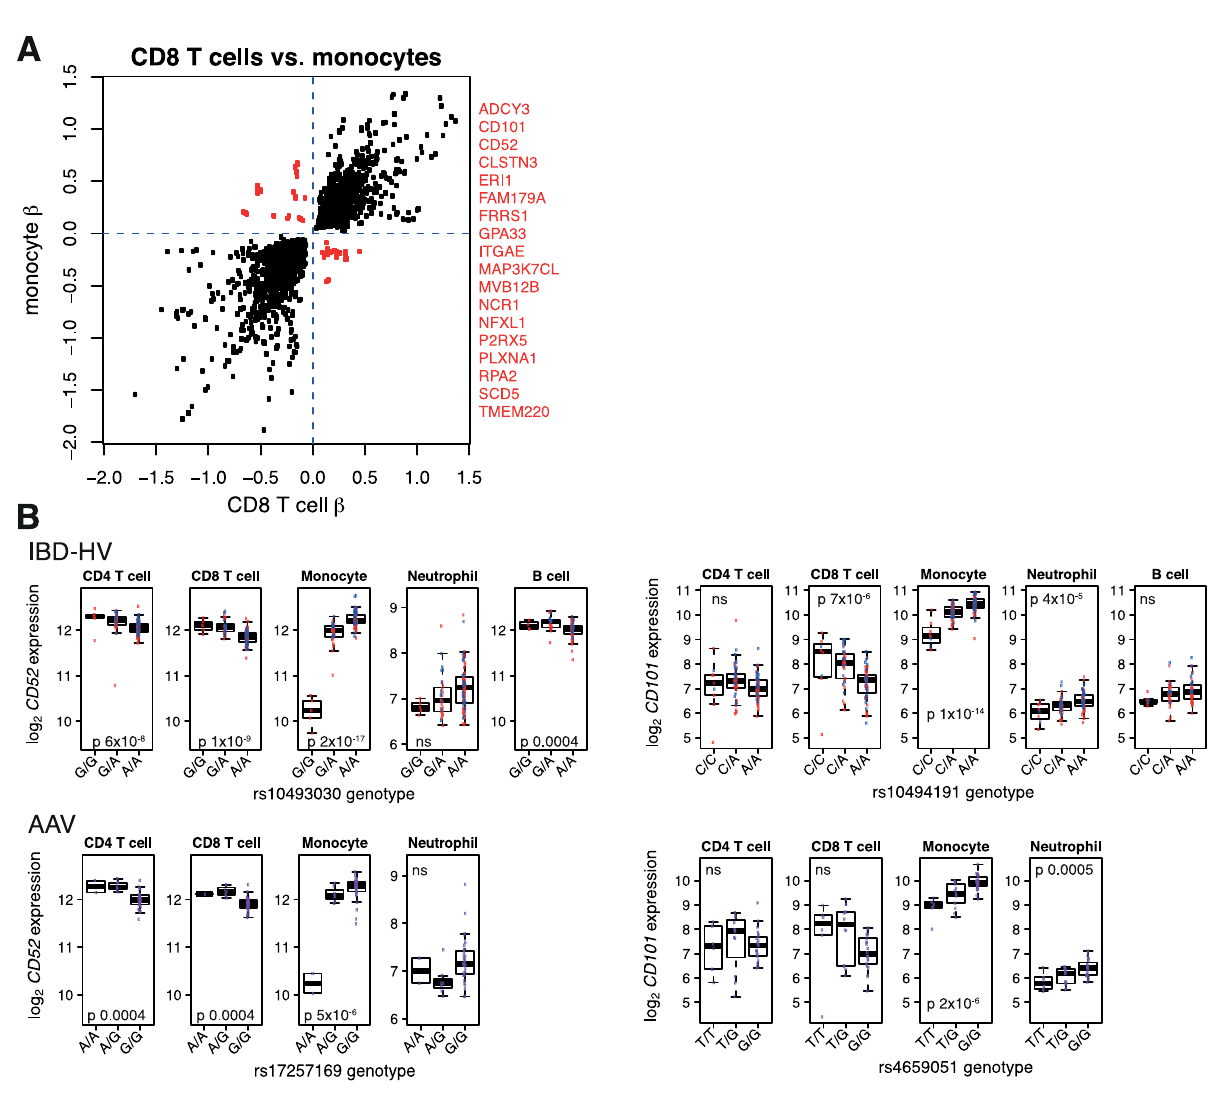
Fig 3. eQTLs with opposing directions of effect between cell types. (A) Detection of eQTLs with opposing directions of effect between CD8 T cells and monocytes (IBD-HV data). Each point represents a SNP-gene association which was significant in both cell types. The axes show the estimated effect size (beta) of genotype on expression in each cell type. SNP-gene pairs with opposing directions of effect between cell types, and the names of these genes, are shown in red. (B) Two examples of such divergent eQTLs. Upper panels: IBD-HV data genotyped on Illumina Human OmniExpress Beadchip (red points = IBD patients, blue = HVs). Lower panels: this observation is replicated in AAV cohort genotyped on Affymetrix SNP 6.0 platform. r 2 1 between rs10493030 and rs17257169. r 2 0.6 between rs10494191 and rs4659051.